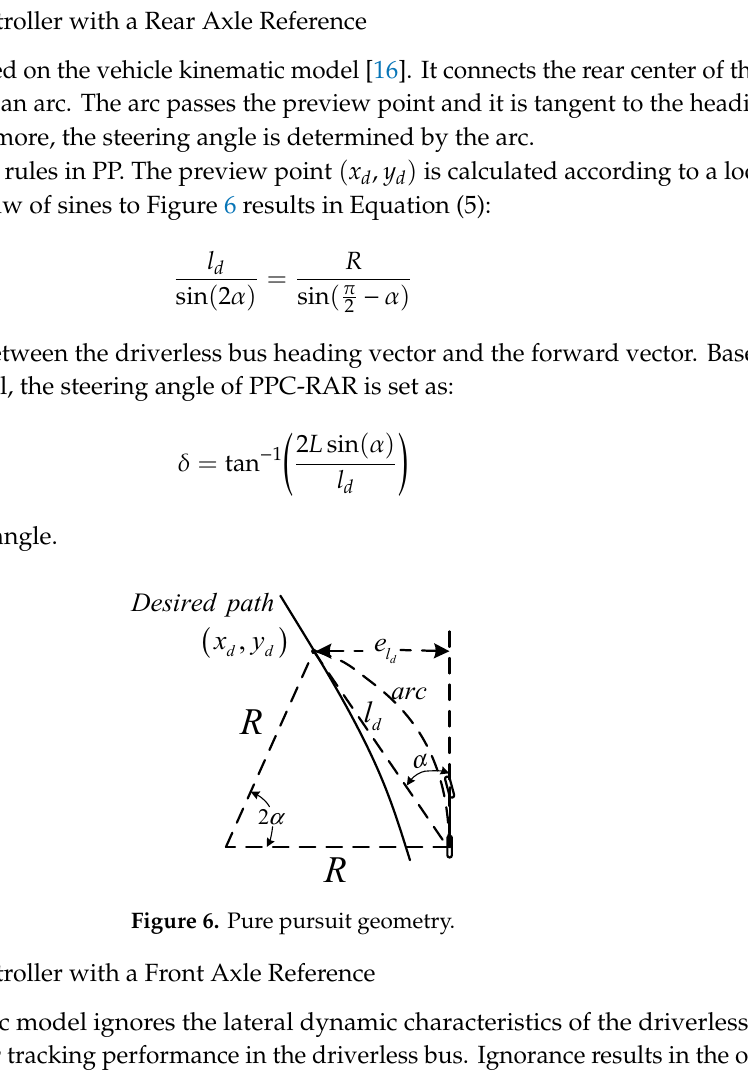
Figure 5. The structure of the lateral controller.